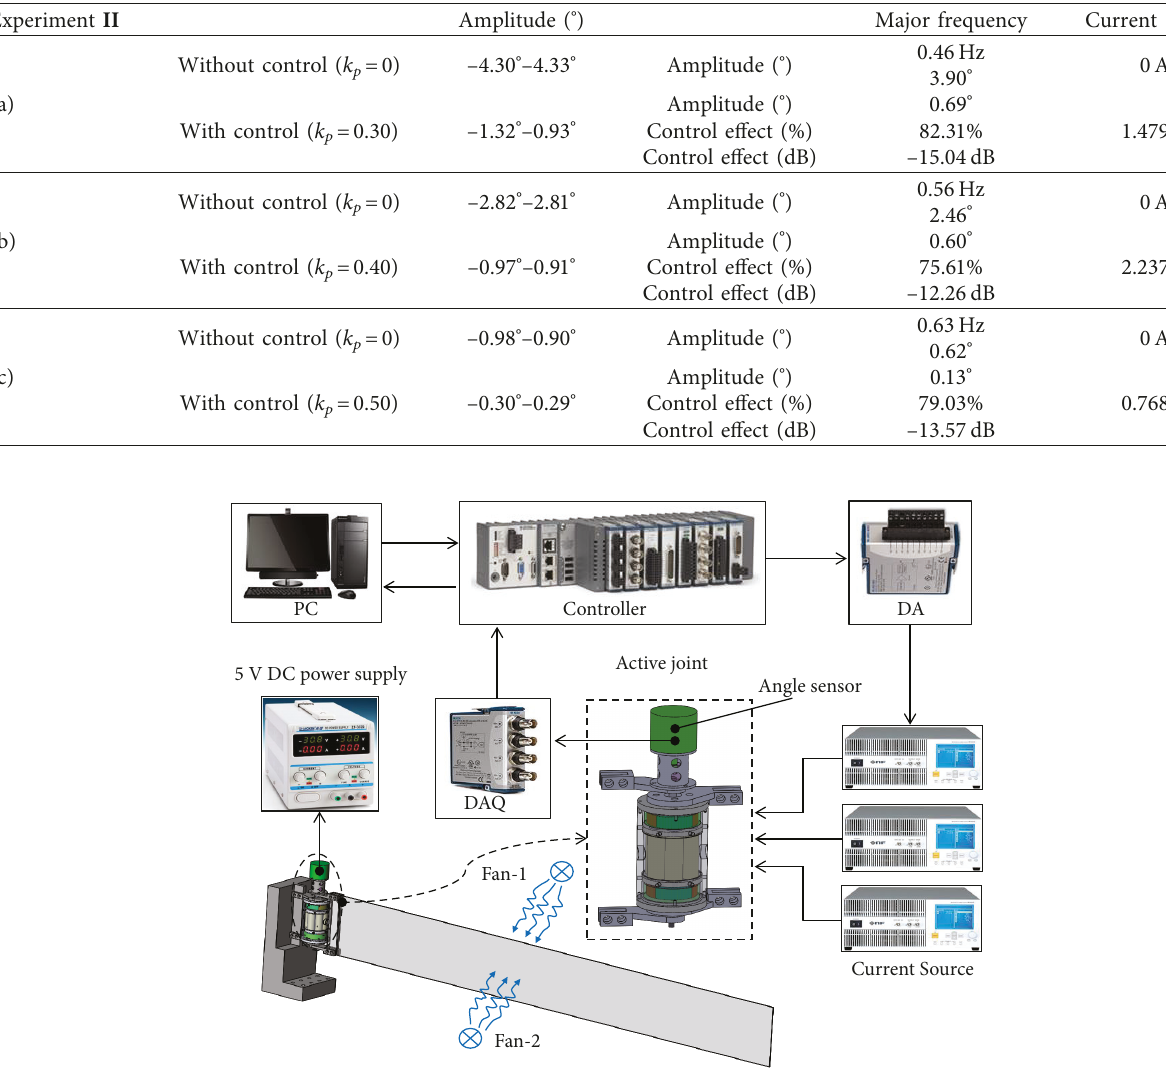
Table 4: Vibration control effect based on the novel active joint in Experiment II .